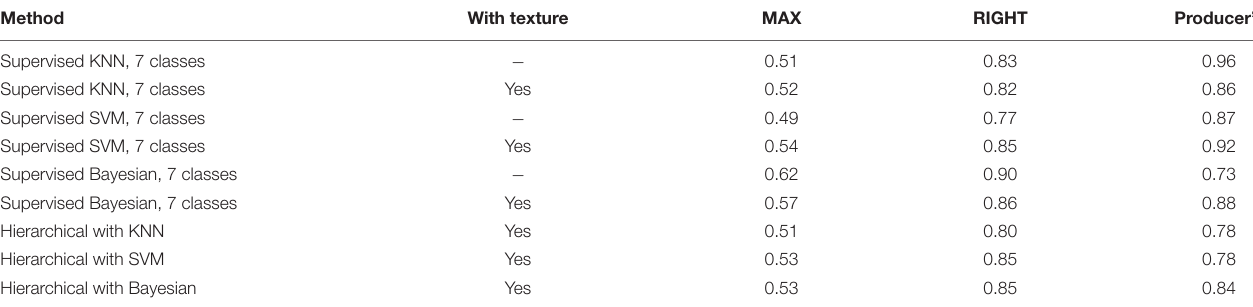
TABLE 2 | Combined accuracies for medusahead and barbed goatgrass in supervised seven-class and hierarchical classifications. Method With texture MAX